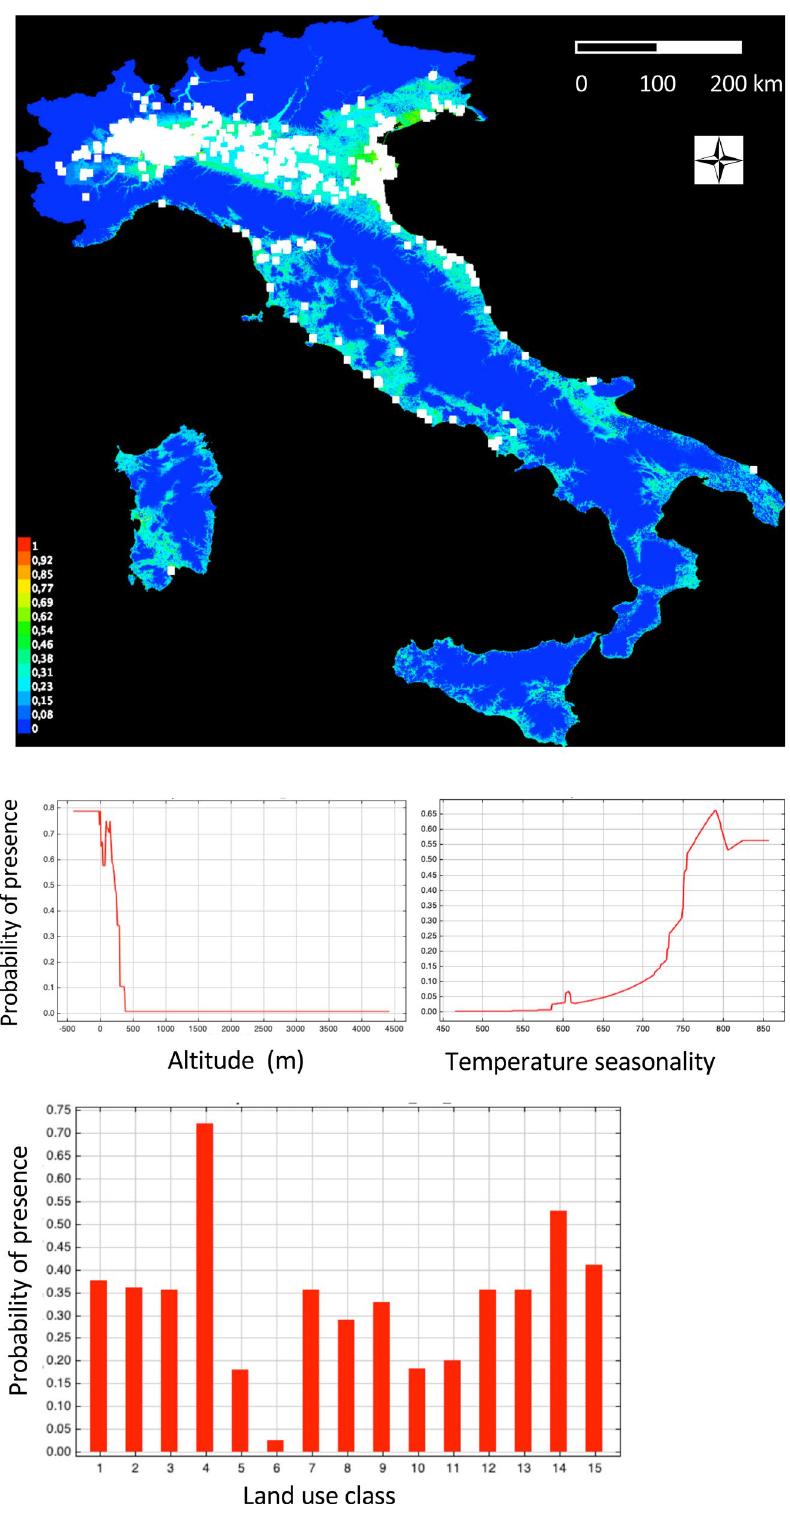
Figure 5. Species distribution model for the sacred ibis in Italy. Temperature seasonaly (Bio4 variable). Land use class names are reported in Table 1. Maps generated using QGIS ver, 3.4